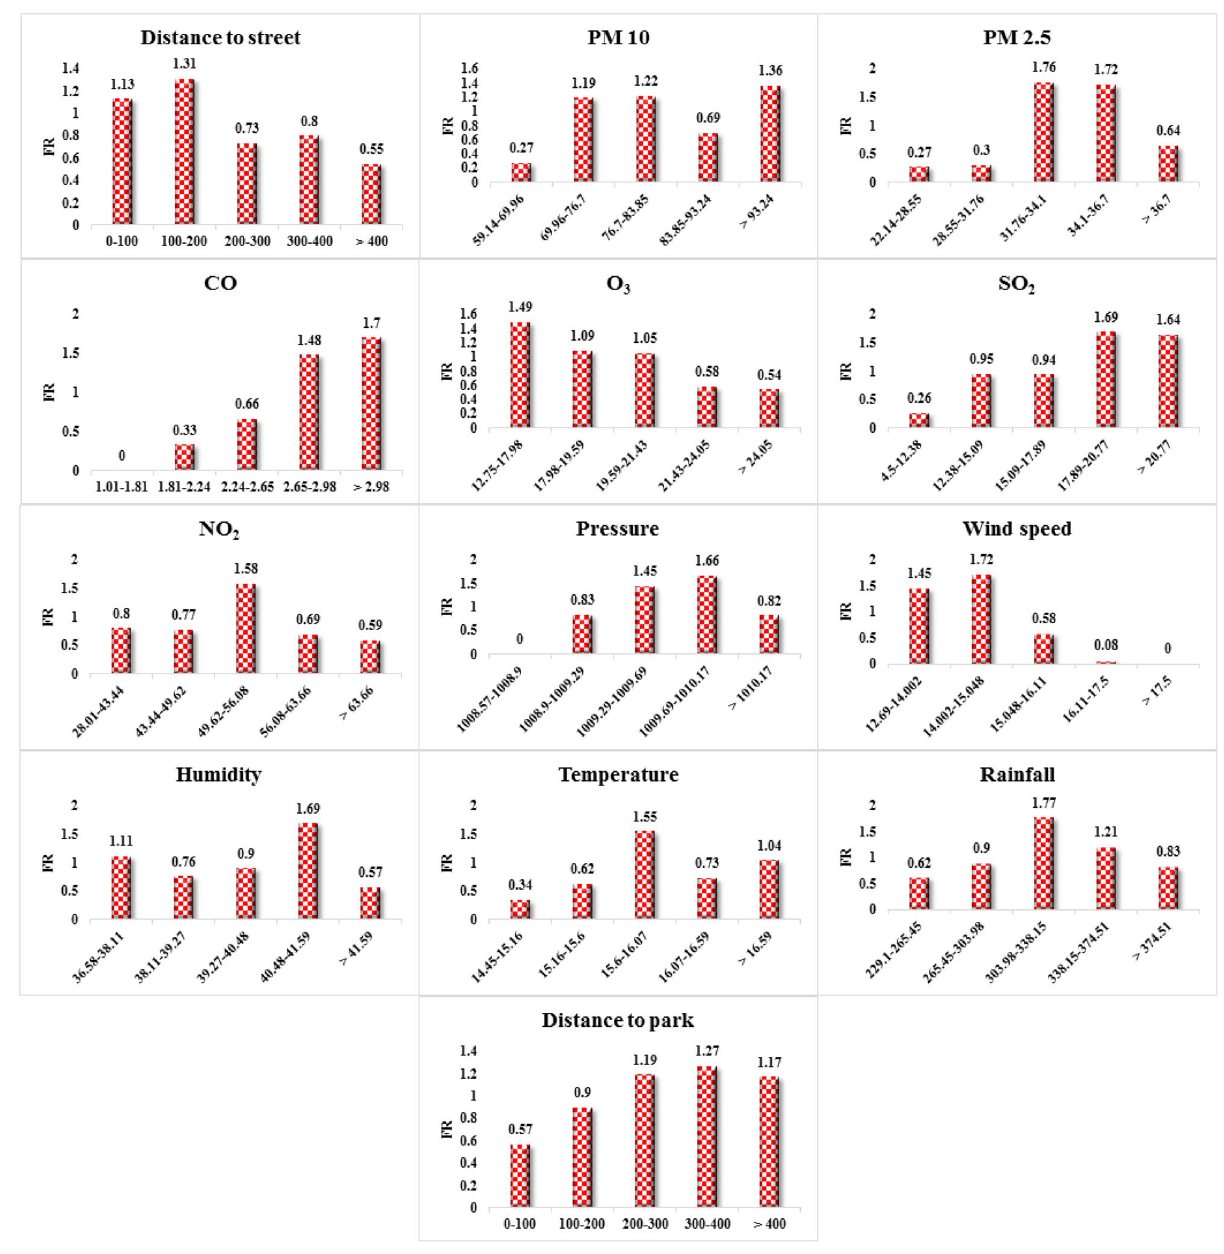
Figure 6. Result of frequency ratio (FR)